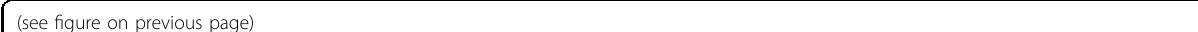
Fig. 1 TGF- β downregulation and ROS generation by TGF- β shRNAs. A Downregulation of TGF- β 1 and TGF- β 2 after infection with adenoviruses expressing TGF- β shRNAs. a Schematic structure of adenoviral vectors expressing TGF- β shRNA. dl324- Δ E1A- Δ E1B- Δ E3-IX-U6-NC (Ad-NC) is a replication-incompetent adenovirus used as the negative control. It contains the scrambled DNA sequence for shRNA, which is under the control of the U6 promoter. dl324- Δ E1A- Δ E1B Δ E3-IX-U6-shTGF- β 1 or - β 2 (Ad-shTGF- β 1 or - β 2) is a replication-incompetent adenovirus expressing human TGF- β 1 or - β 2 shRNA. NC negative control. b Downregulation of human transforming growth factor β 1 (TGF- β 1) or β 2 by adenovirus expressing shTGF- β 1 or - β 2. Human A375 and HPAC cells were infected with various MOIs of adenovirus expressing shRNA targeting human TGF- β 1 (Ad-shTGF- β 1) or human TGF- β 2 (Ad-shTGF- β 2) or scrambled RNA (Ad-NC). TGF- β 1 or - β 2 mRNA was assayed by quantitative real-time polymerase chain reaction (qRT-PCR), and c protein levels were assayed by enzyme-linked immunosorbent assay (ELISA). MOI multiplicity of infection, NC negative control. Error bars represent the standard error from three independent experiments. B Various cancer cell lines were treated with adenovirus expressing shTGF- β 1 or - β 2 for 48 h and incubated for an additional 14 days for clonogenic assays. The numbers indicate the relative ratio of clone numbers to those of Ad-NC. C Global transcriptome analysis of TGF- β downregulation. Expression values of differentially expressed genes are shown in heat map format. Gene expression levels are visualized as row standardized z scores ranging from green ( − 1) to red ( + 1) across all samples. The rows are organized by hierarchical clustering analysis with complete linkage and Euclidean distance as a measure of similarity from samples of A375 cells (NC, shTGF- β 1, shTGF- β 2) (Left) and HPAC cells (NC, shTGF- β 1, shTGF- β 2) (Right). NC, A375, and HPAC cells infected with adenovirus expressing nonsense shRNA as a negative control at 100 MOI; shTGF- β 1 or - β 2; A375 and HPAC cells infected with adenoviruexpressing TGF- β 1 or - β 2 shRNA at 100 MOI. D Effect of adenovirus expressing shTGF- β 1 or shTGF- β 2 in various cancer cell lines. Each cell line was treated with adenovirus expressing shTGF- β 1 or shTGF- β 2 at 100 MOI. After 48 h, the expression levels of p-p38, p38, p-HSP27, HSP27, p-ERK, ERK, p-JNK, JNK, and GAPDH were detected via western blot analysis. E Pancreatic normal cell lines were treated with adenovirus expressing shTGF- β 1 or - β 2 at 100 MOI. After 48 h, the expression levels of p-p38, p38, p-HSP27, HSP27, p-ERK, ERK, p-JNK, JNK, and GAPDH were detected via western blot analysis. F ROS generation was induced by shTGF- β 1- and shTGF- β 2-expressing adenoviruses. A375 cells, HPAC cancer cells, and pancreatic normal cells were infected with adenovirus expressing shTGF- β 1 or - β 2 at 100 MOI, respectively, after 48 h of incubation with DCF-DA (20 μ M, 1 h) for the detection of ROS using a fl uorescent reader and microscopy. Cell viability was tested via an MTS viability assay after 48 h of infection. Error bars represent the standard error from three independent experiments. p Values <0.01 indicate a very signi fi cantly different viability of Ad-shTGF- β 1 or - β 2 compared to the control (Ad-NC). G Effects of NAC treatment with adenovirus expressing TGF- β 1 or - β 2 shRNA in melanoma and pancreatic cancer cells. A375 (top) or HPAC (bottom) cells were infected with adenovirus expressing shTGF- β 1 or - β 2 at 100 MOI, respectively. After 6 h, infected cells were treated with NAC (10 mM) for 42 h and then incubated with DCF-DA (20 μ M, 1 h) for the detection of ROS using a fl uorescent reader and microscopy. H A375 and HPAC cells were infected with adenovirus expressing shTGF- β 1 or - β 2. After 6 h, infected cells were treated with NAC (10 mM) for 42 h, and then the expression levels of PARP, p-ASK1, ASK1, p- p38, p38, p-JNK, JNK, Trx, and GAPDH were detected by western blot